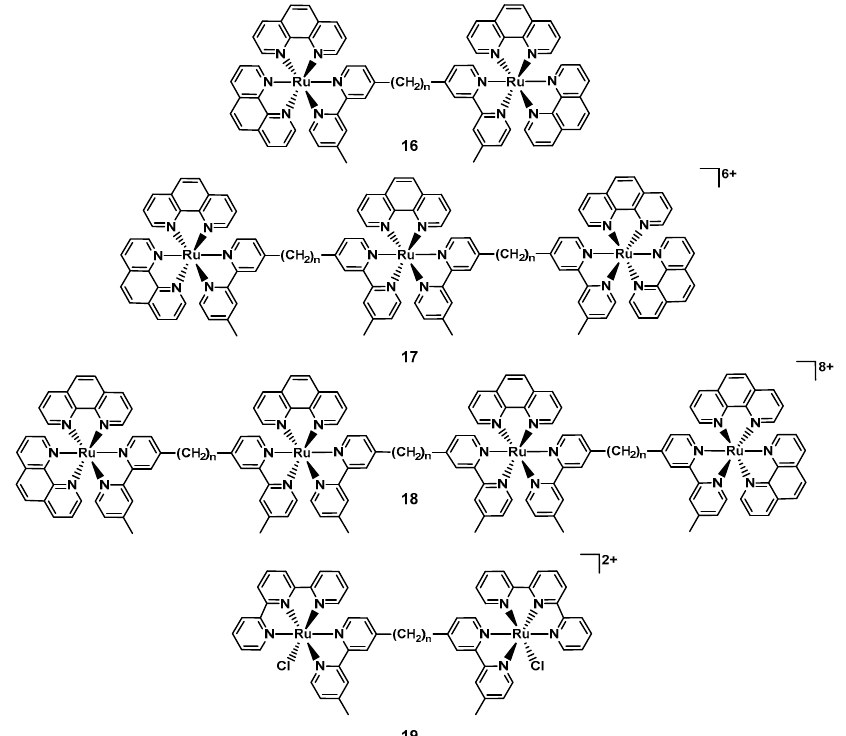
Figure 7. Example structures of the polynuclear ruthenium complexes reported by the groups of Keene and Collins ( n indicates the length of the alkyl chain).